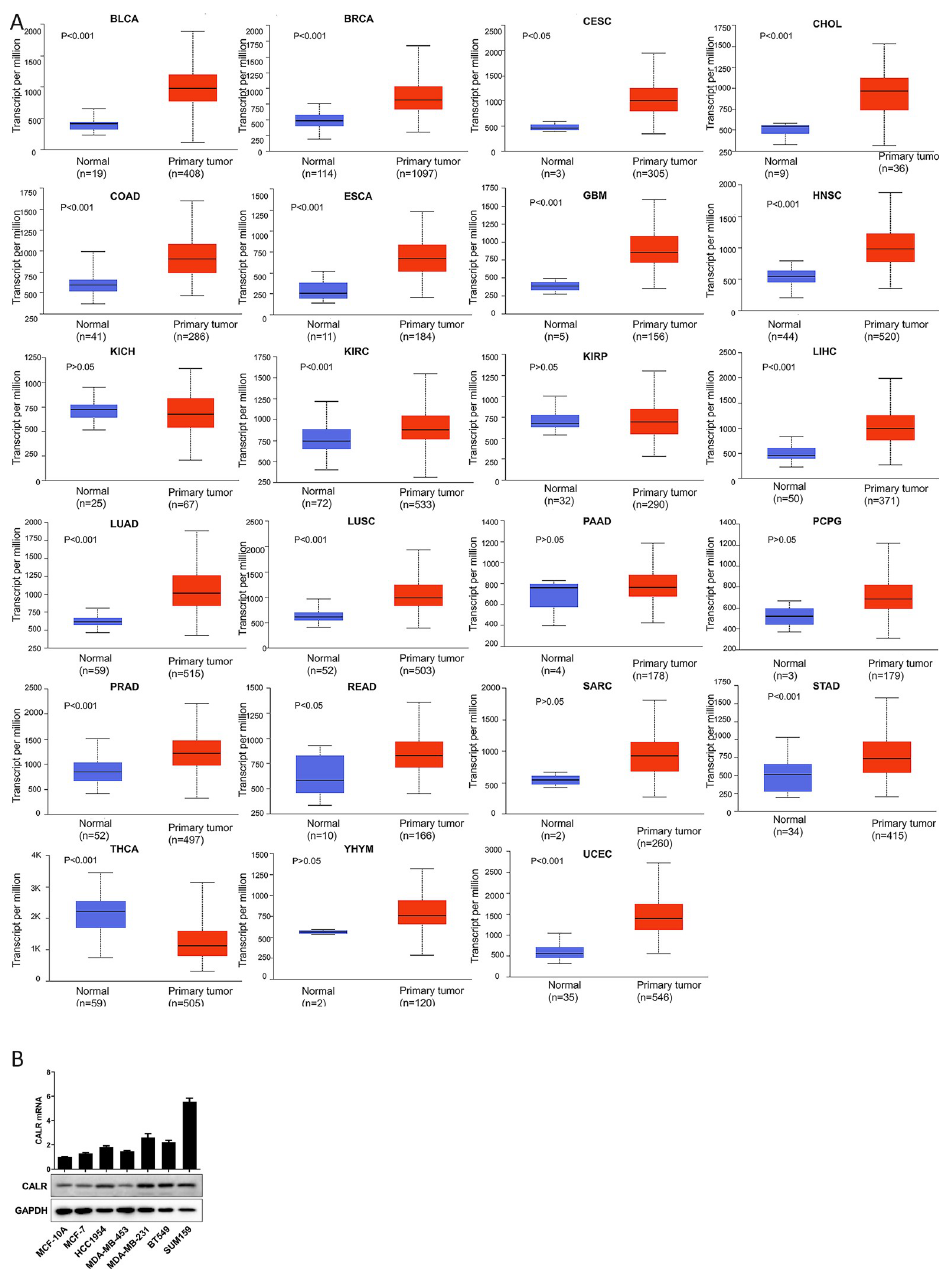
Fig 2. The differential expression of CALR in human normal tissues and cancers by UALCAN database analysis. Note: P value < 0.05 is considered statistically significant.